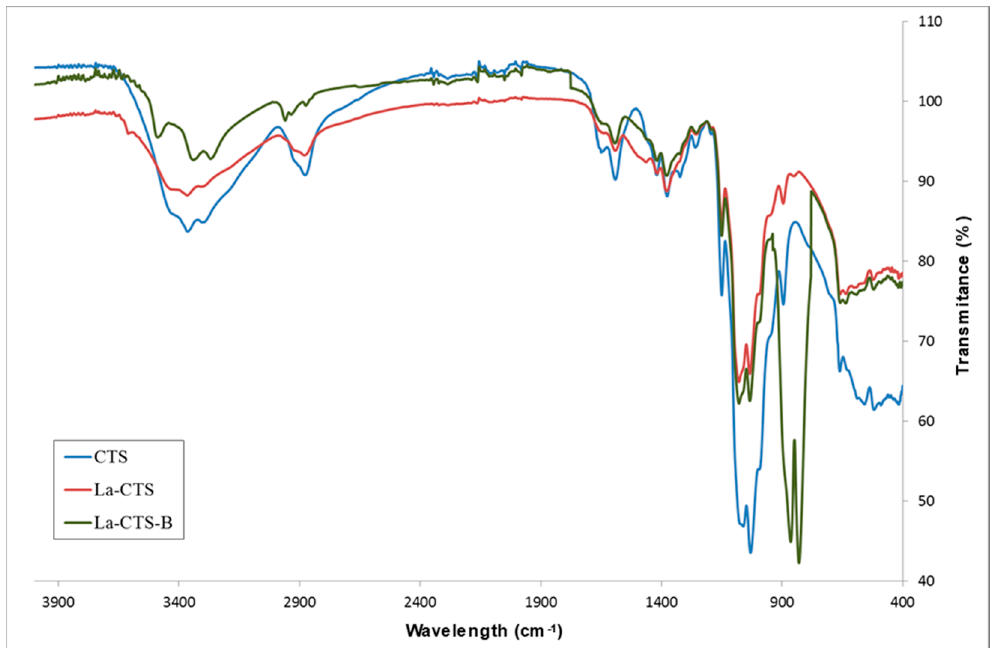
Figure 1. The FTIR spectra of unmodified chitosan (CTS); chitosan attached with La(III) before (La-CTS) and after (LA-CTS-B) boron adsorption.